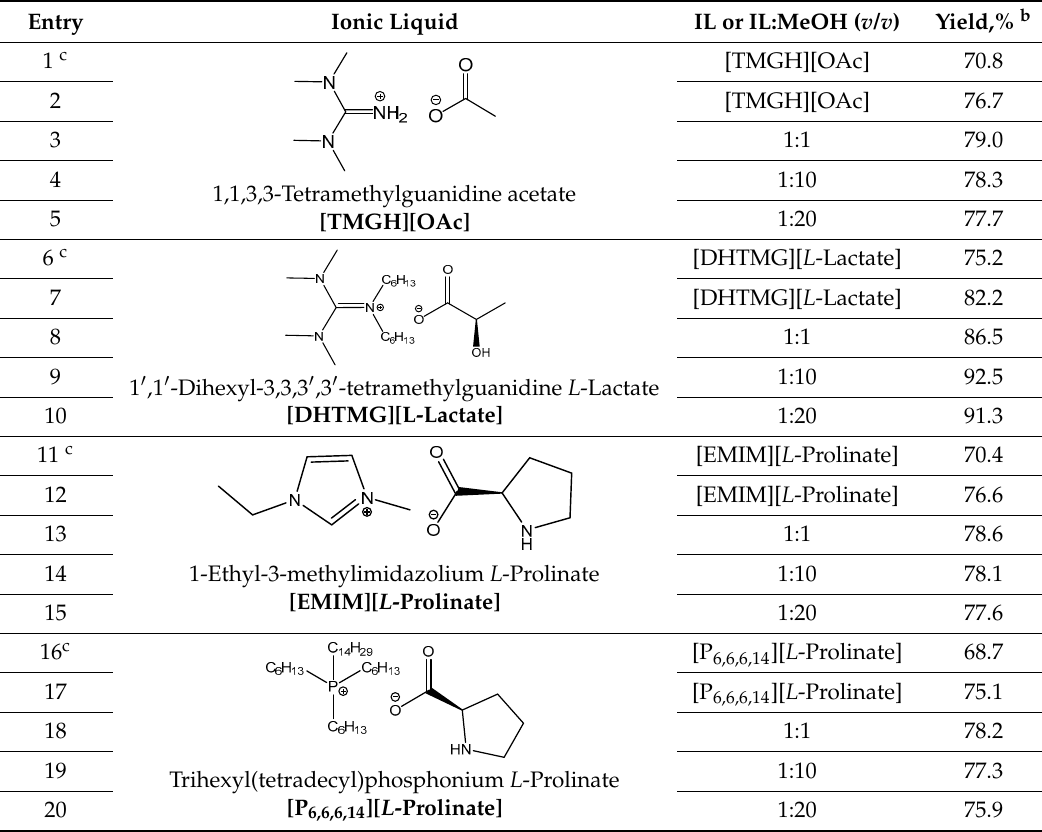
a Reaction conditions: 5 mol% of catalyst 2 , IL or a mixture of IL + MeOH (2 mL), TMSCN (0.6 mmol) and aldehyde (0.4 mmol). Reaction time: 8 h. b Determined by 1 H NMR analysis of crude products (see Experimental part). c Without catalyst 2 .